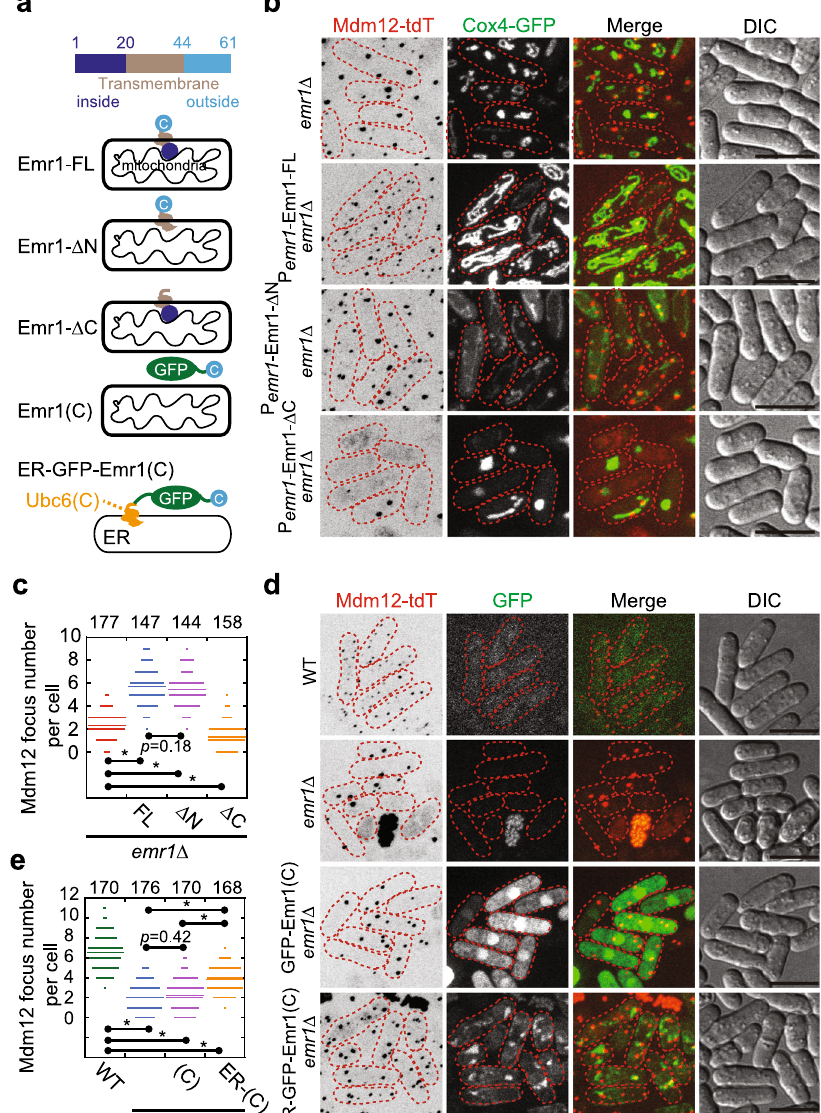
Fig. 6 The C-terminus of Emr1 is required for regulating the number of ERMES foci. a Diagrams illustrating the different modes of localization of the indicated Emr1 truncated mutants and the chimera ER-GFP-Emr1(C). ER is the ER-localizing fragment from Ubc6 (including its C-terminus (a.a. 226 – 227) and the adjacent transmembrane domain (a.a. 207 – 225)). b Maximum projection images of emr1 Δ cells expressing Mdm12-tdTomato, Cox4-GFP, and the indicated Emr1 proteins (from the emr1 promoter). Both full-length and Δ N, but not Δ C, of Emr1 were able to restore the normal number of Mdm12- tdTomato foci. Dashed lines mark the edge of cells. Scale bar, 10 μ m. c Quanti fi cation of Mdm12-tdTomato foci in the indicated cells in b . Statistical analysis was performed by one-way ANOVA (F(3, 622) = 530.26, p < 0.001), followed by Tukey honest signi fi cance difference test (the p -values are indicated on the graph; * p < 0.001). n indicates cell number observed for quanti fi cation. d Maximum projection images of the indicated cells expressing Mdm12- tdTomato and the indicated GFP-fused proteins. Emr1(C), the C-terminus of Emr1; ER-Emr1(C), an ER-targeting peptide fused to the N-terminus of the cytoplasm region of Emr1. Note that ER-Emr1(C), but not Emr1(C), was able to partially rescue the number of Mdm12 foci. Dashed lines mark the edge of cells. Scale bar, 10 μ m. e Quanti fi cation of Mdm12-tdTomato foci in the indicated cells in d . Statistical analysis was performed by one-way ANOVA (F(3, 680) = 373.86, p < 0.001), followed by Tukey honest signi fi cance difference test (the p -values are indicated on the graph; * p < 0.001). n indicates cell number observed for quanti fi